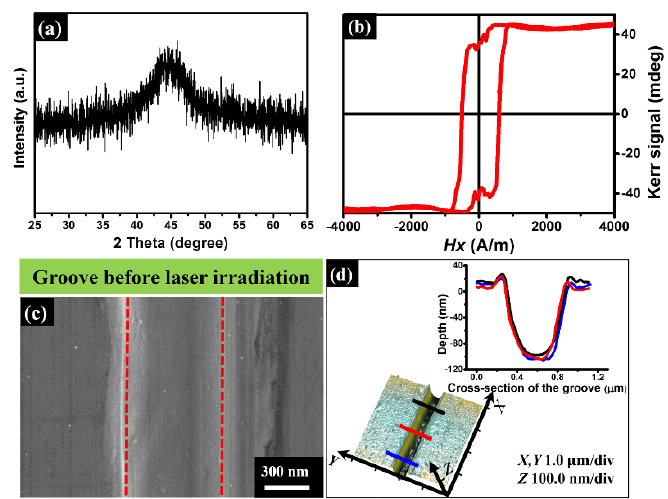
Figure 2. ( a , b ) Measured XRD curve and hysteresis loop for the sample of Fe-based metallic glass before the femtosecond laser irradiation. ( c , d ) SEM and AFM images of the mechanically scratched groove on the surface of Fe-based metallic glass. The two red dashed lines identify the boundaries of the groove. Upper-right inset in ( d ) shows the measured cross-section profiles at three different positions marked by the red, black, and blue lines.